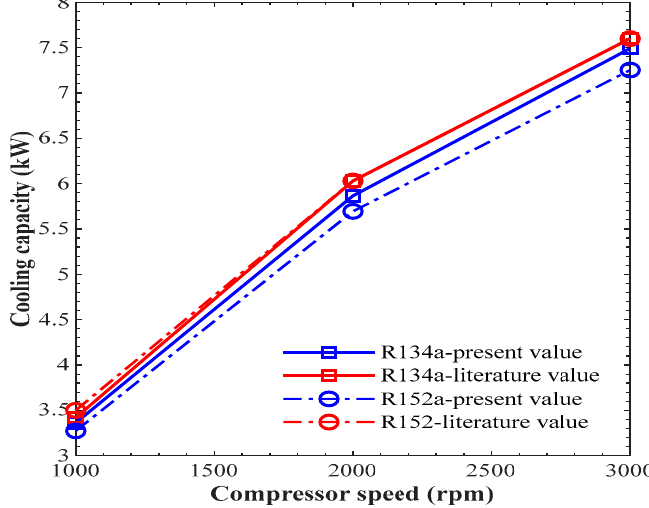
Figure 8 . Comparison of cooling capacity vs. compressor speed .